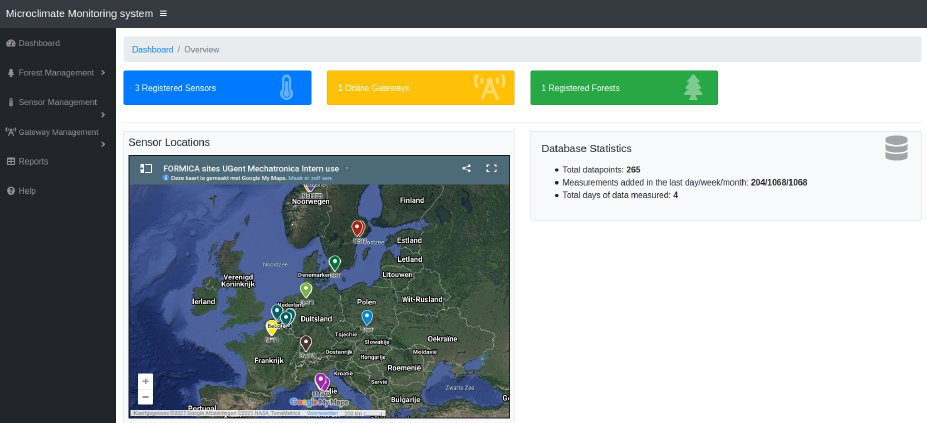
Figure 3. Web interface for node status monitoring and